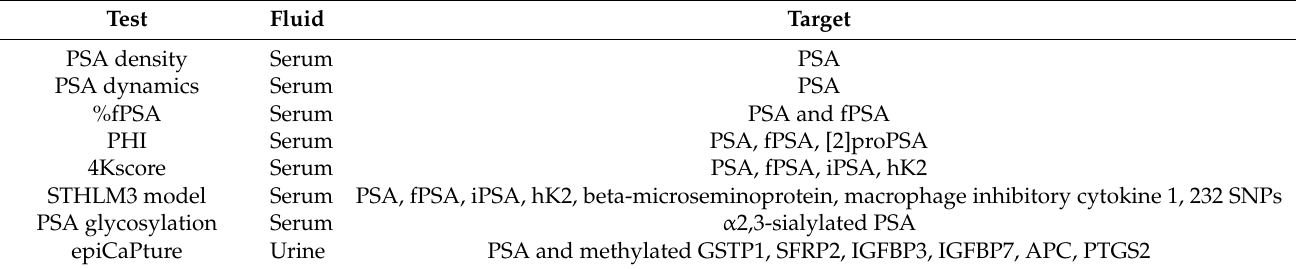
Table 2. Overview of PSA-based diagnostic and prognostic assays. fPSA, free PSA; hK2, human kallikrein 2; iPSA, intact PSA; PHI, Prostate Health Index; PSA, prostate specific antigen; SNPs, single nucleotide